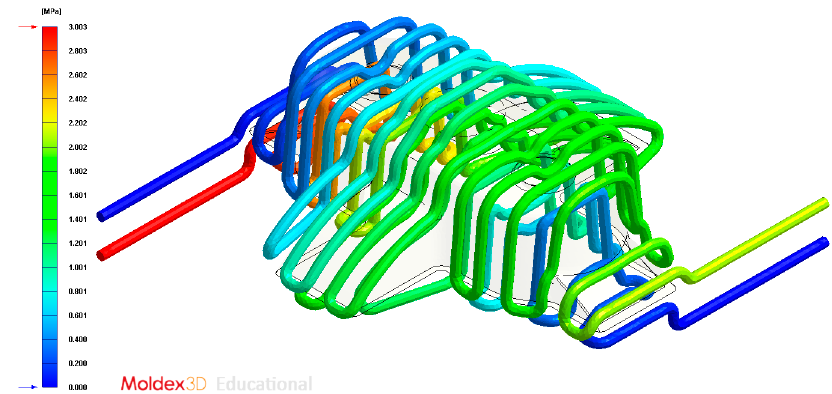
Figure 17. Pressure (MPa) of the coolant along the cooling system, Case A.